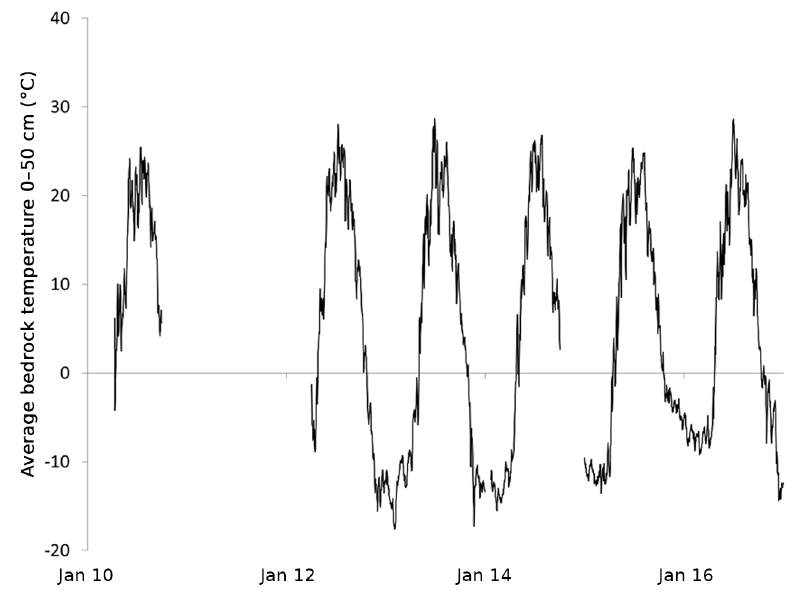
Figure 14. Daily average 0–0.5m bedrock temperatures near the exposed bedrock ridge climate tower in